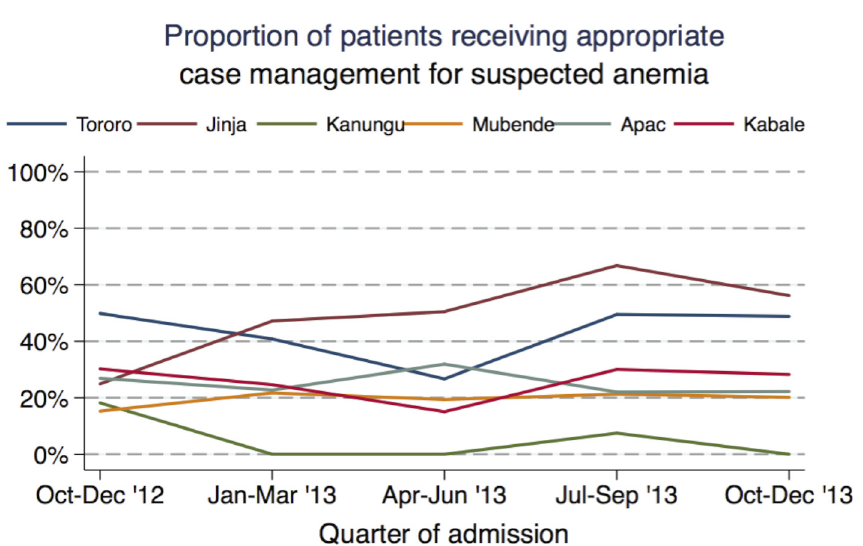
Fig 4. Trends in appropriate inpatient case management of suspected anemia, by health